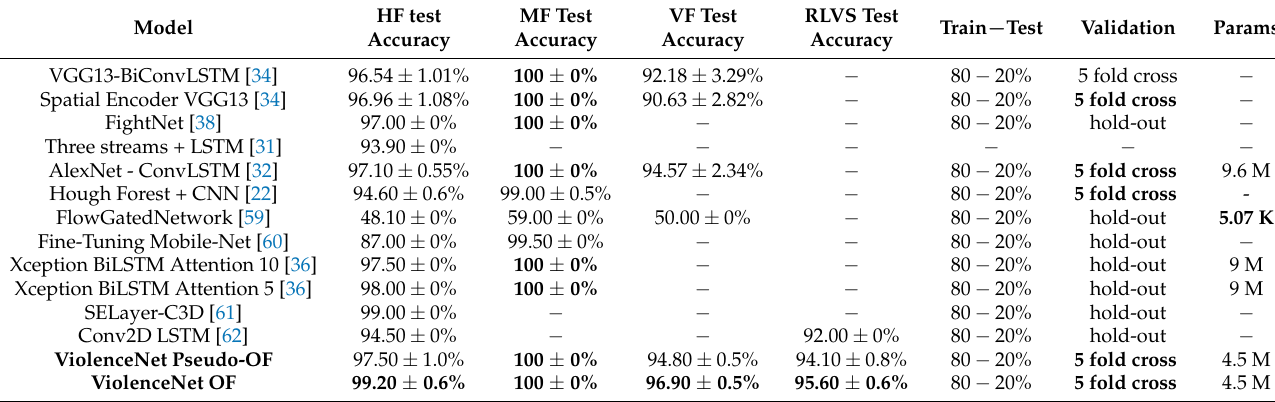
Table 4. State of the art for HF, MF, VF and RLVS datasets. OF stands for optical